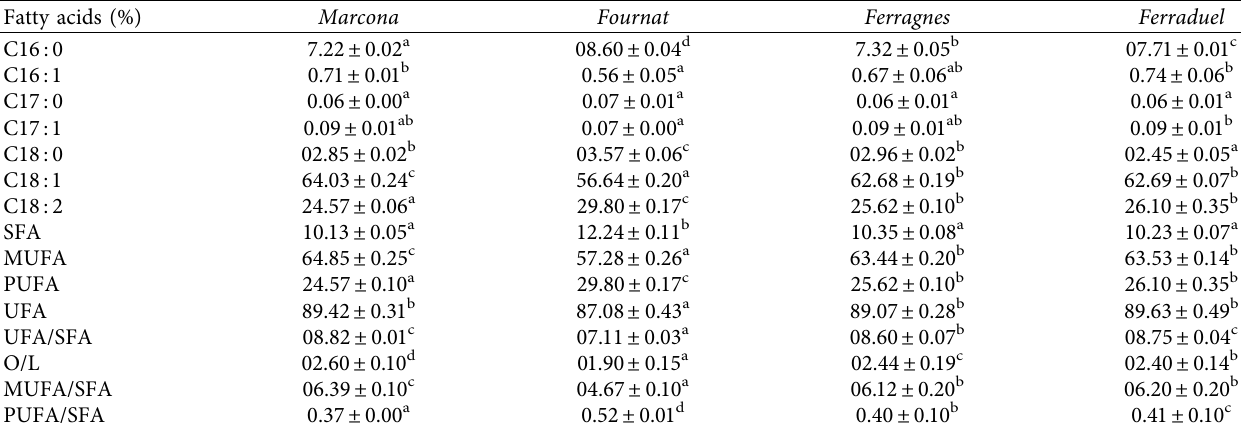
Table 4: Fatty acid compositions of four almond oil varieties produced in eastern